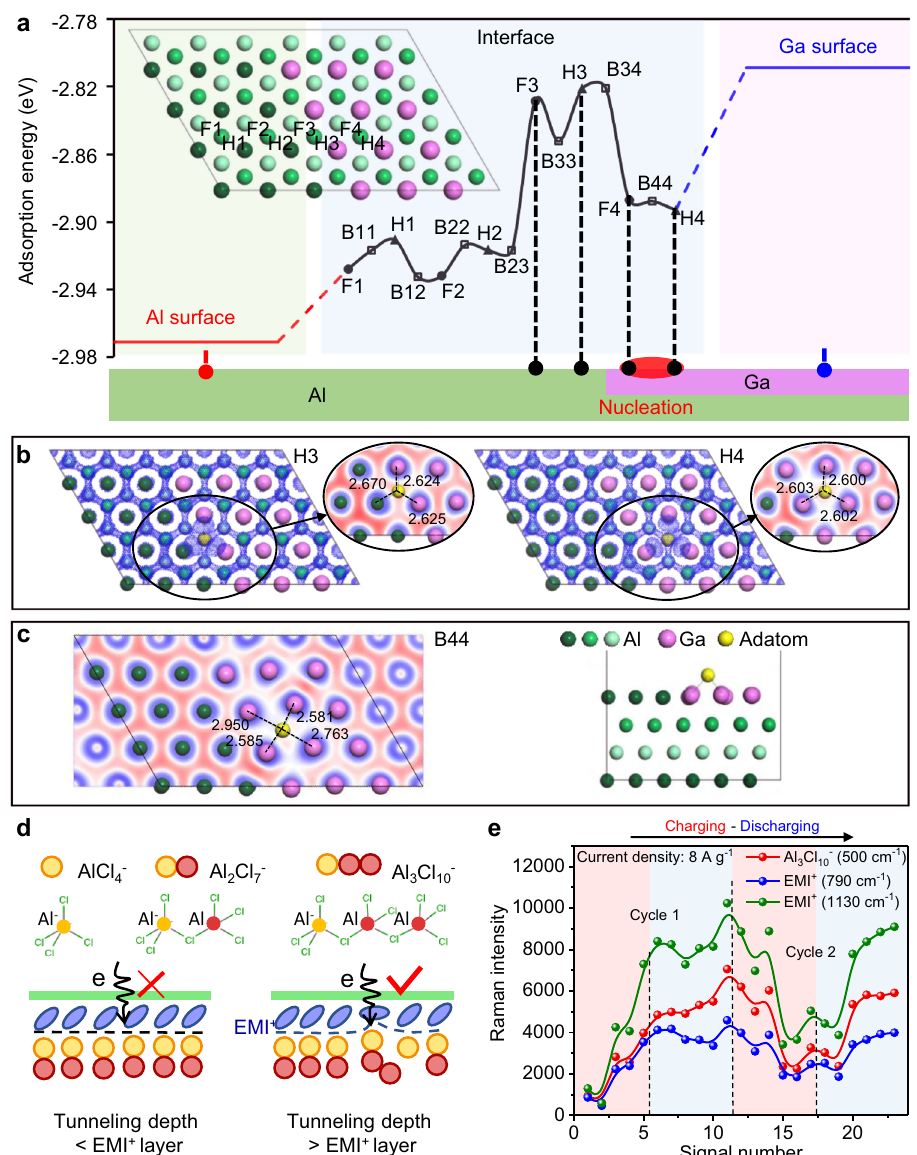
Fig. 4 Density-functional theory (DFT) calculations reveal the nucleation sites of Al adatom and dynamic nature of the electric double layers (EDLs). a Adsorption energy of Al on different hcp (H), fcc (F), and bridge (B) positions of Al/Ga interface compared with on pure Al and Ga surfaces. The energetically favorable adsorption near the Al/Ga boundary creates a potential nucleation site. b Differential charge density of H3 and H4 adsorption sites. The H4 site exhibits somewhat stronger localization of electrons at the Al-Ga bond, accompanied by the formation of bonds with adatom, making it the most favorable adsorption site. c The B44 site shows the disappearance of barrier at bridge position between fcc and hcp sites due to the lowering of local symmetry near the interface. d Schematic illustration of the dynamic transition in EDLs. Reaction intermediate (Al 3 Cl 10 - ) triggers recon fi guration for EMI + . e the intensity variation with time for Al 3 Cl 10 − and EMI + indicates a coordinated change for both ion species during charging (within red shade) and discharging (within blue